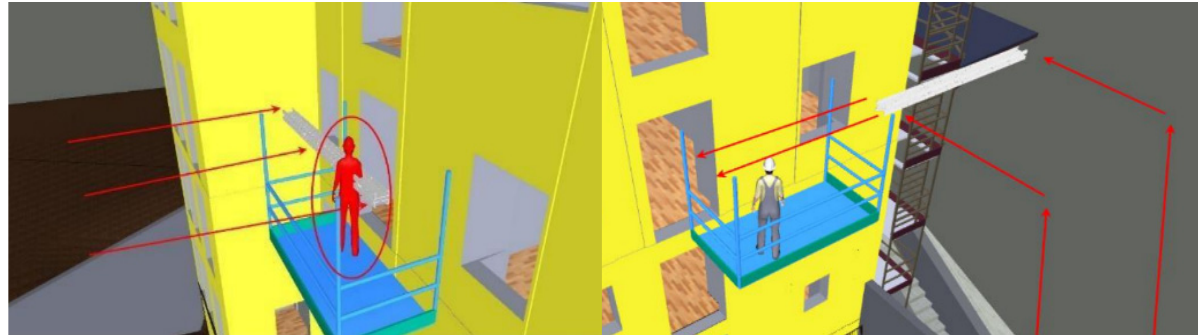
Figure 20. Study of a guardrail location.